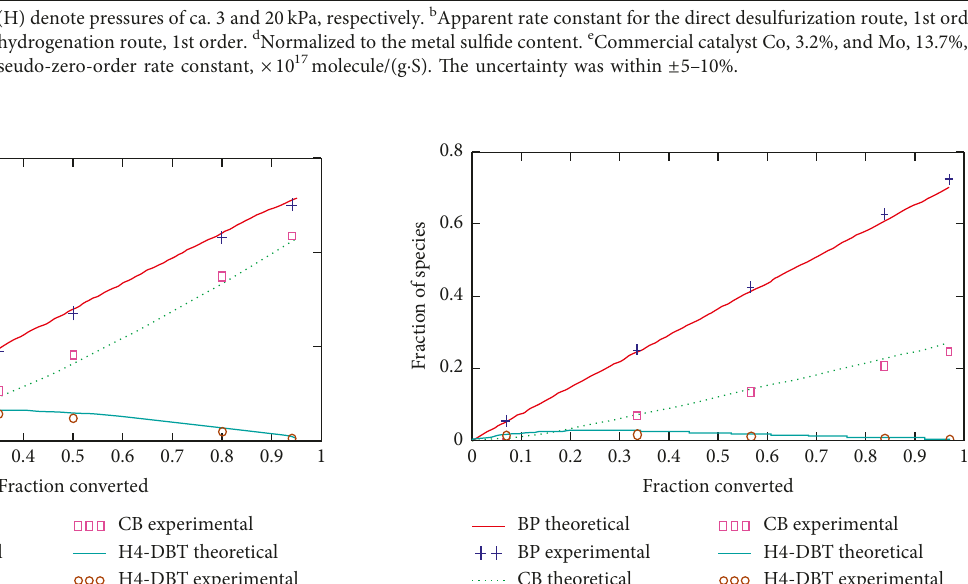
(Table 2) between Co and Mo atoms. A synergistic effect of